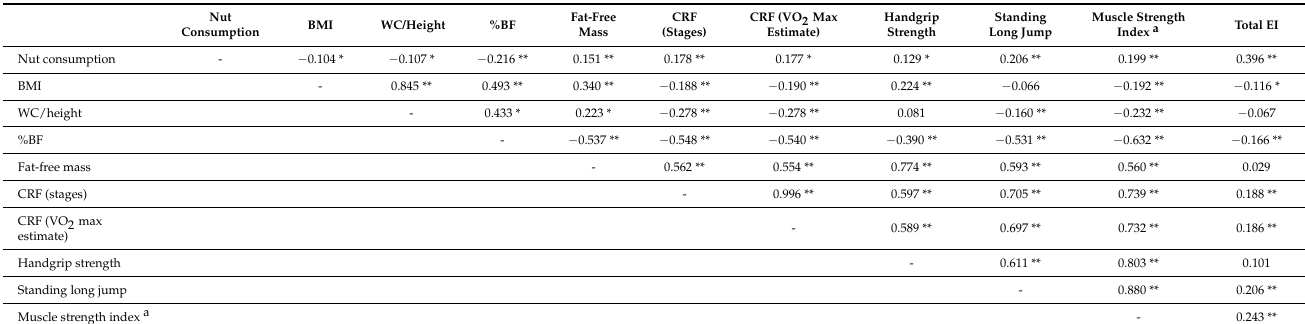
Table 2. Bivariate correlations between nut consumption with body composition, cardiorespiratory fitness (CRF), muscular strength (standing long jump, handgrip strength and muscular strength index) and total energy intake (EI). Nut